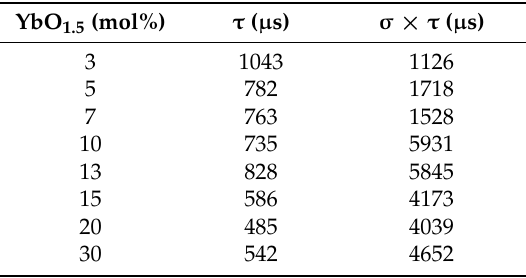
Figure 7. PL decay curves of aluminosilicate bulk glass samples doped with 5–30 mol% YbO 1.5 . Table 1. Lifetime, τ and σ × τ values for Yb-doped phosphosilicate glasses.